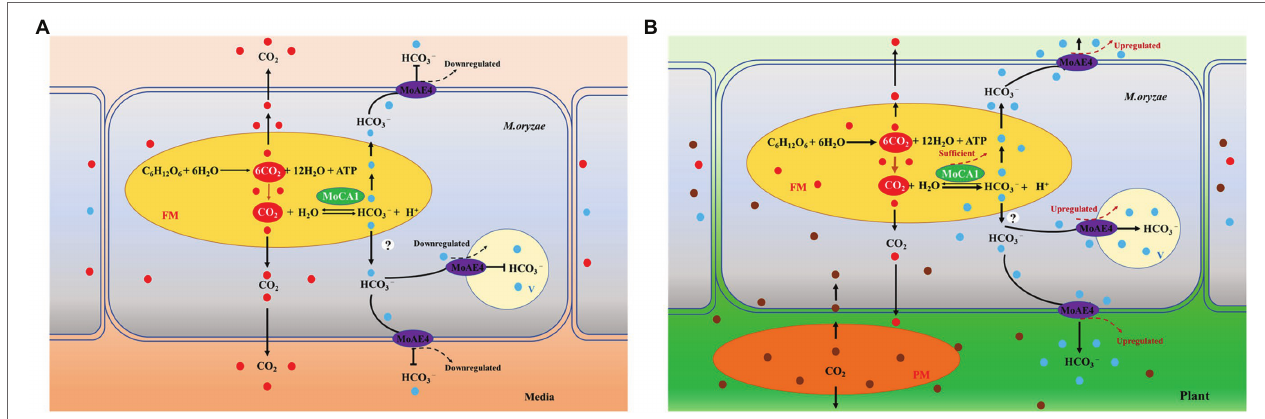
FIGURE 6 | A pathogenic model mediated by MoAE4/MoCA1 system. (A) Magnaporthe oryzae is under cultivation conditions. (B) Magnaporthe oryzae infects the host cells. FM, fungal mitochondrion; PM, plant mitochondrion; V, vacuole; and MoAE4, M. oryzae bicarbonate